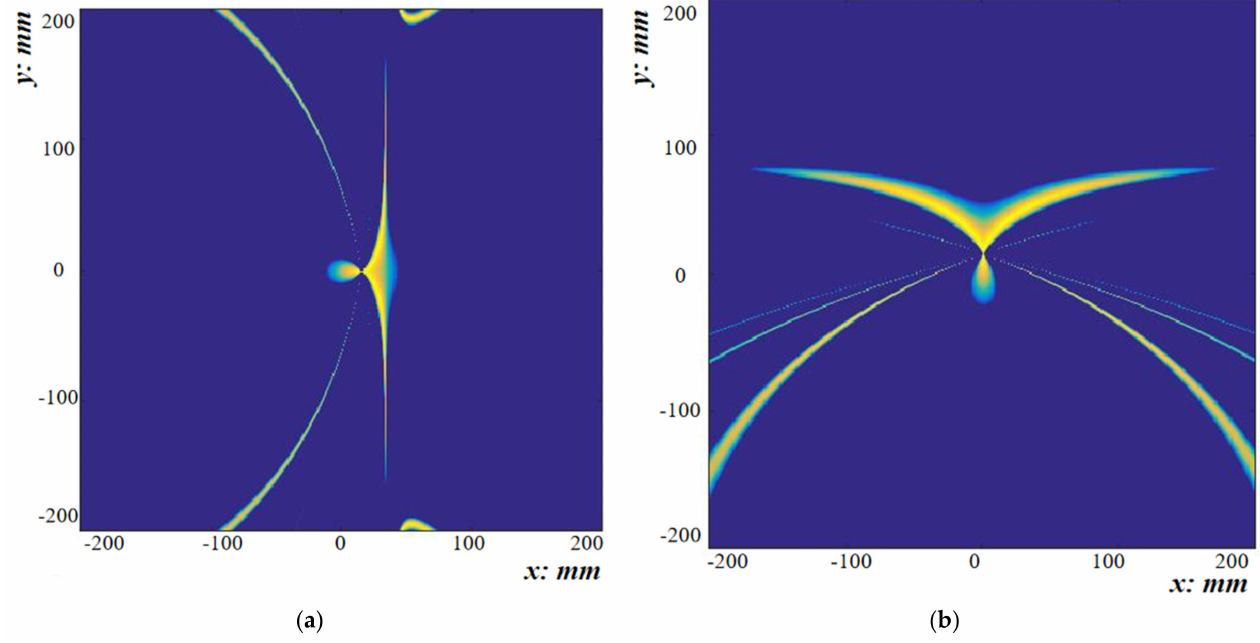
Figure 7. ( a ) Imaging result on the x -axis. ( b ) Imaging result on the y -axis.